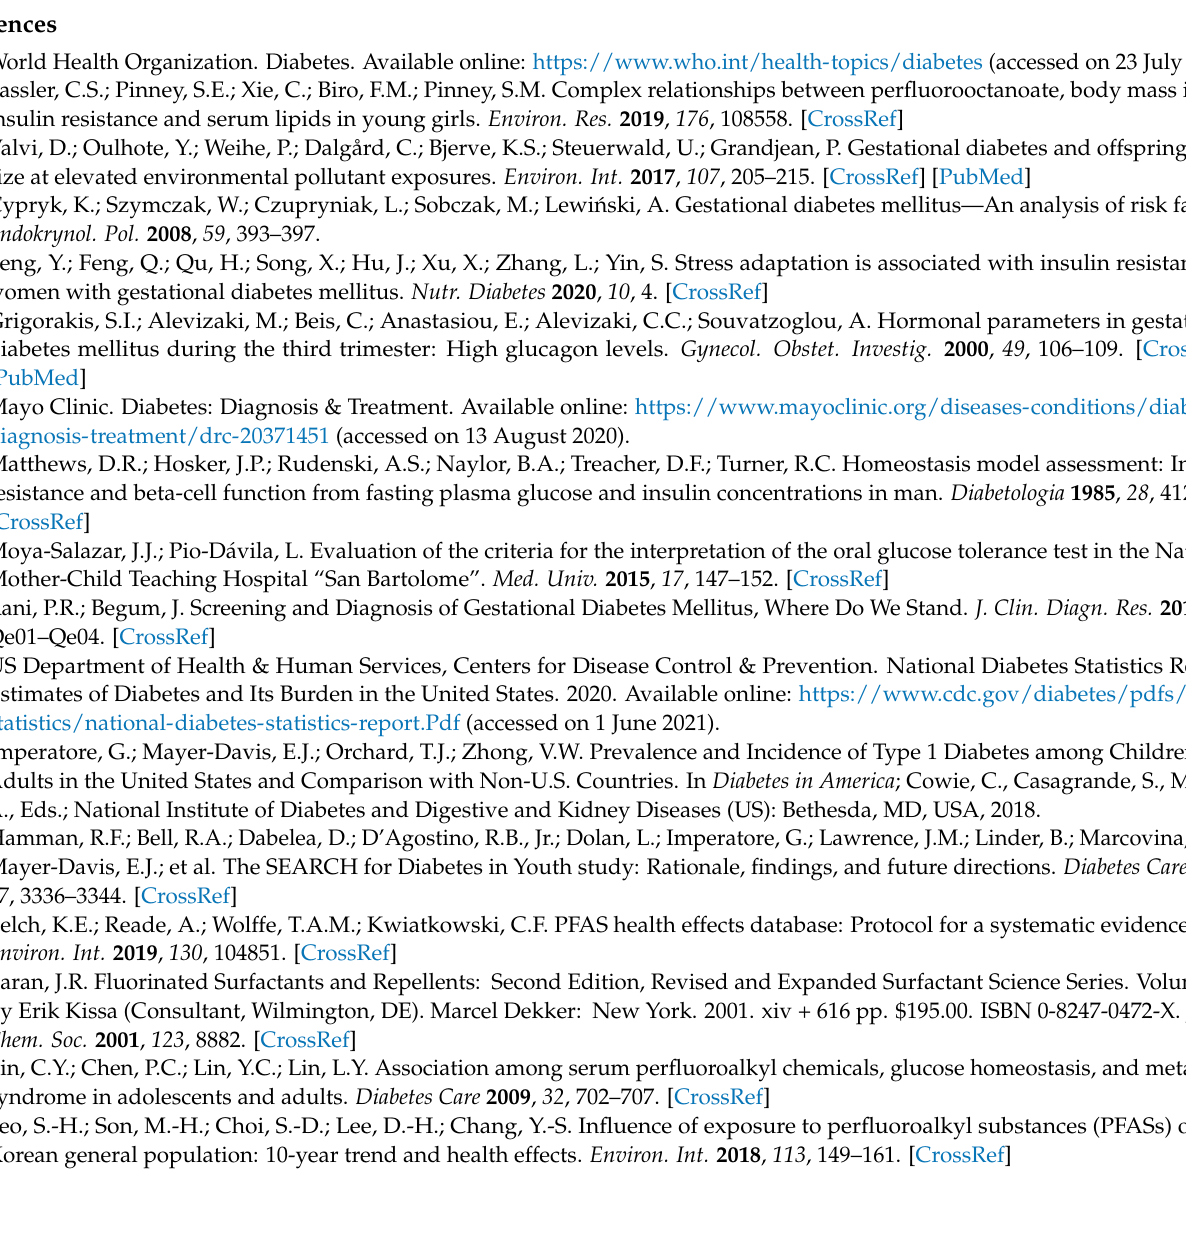
Table S4: PFAS and Prediabetes or Unspecified Diabetes; Table S5: PFAS and Insulin Resistance or Glucose